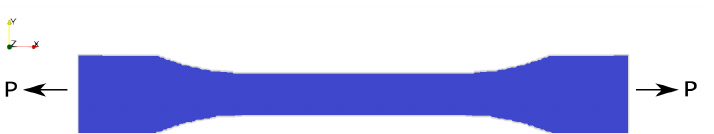
Figure 5. An illustration of the ISO 527-2 CAD model with boundary